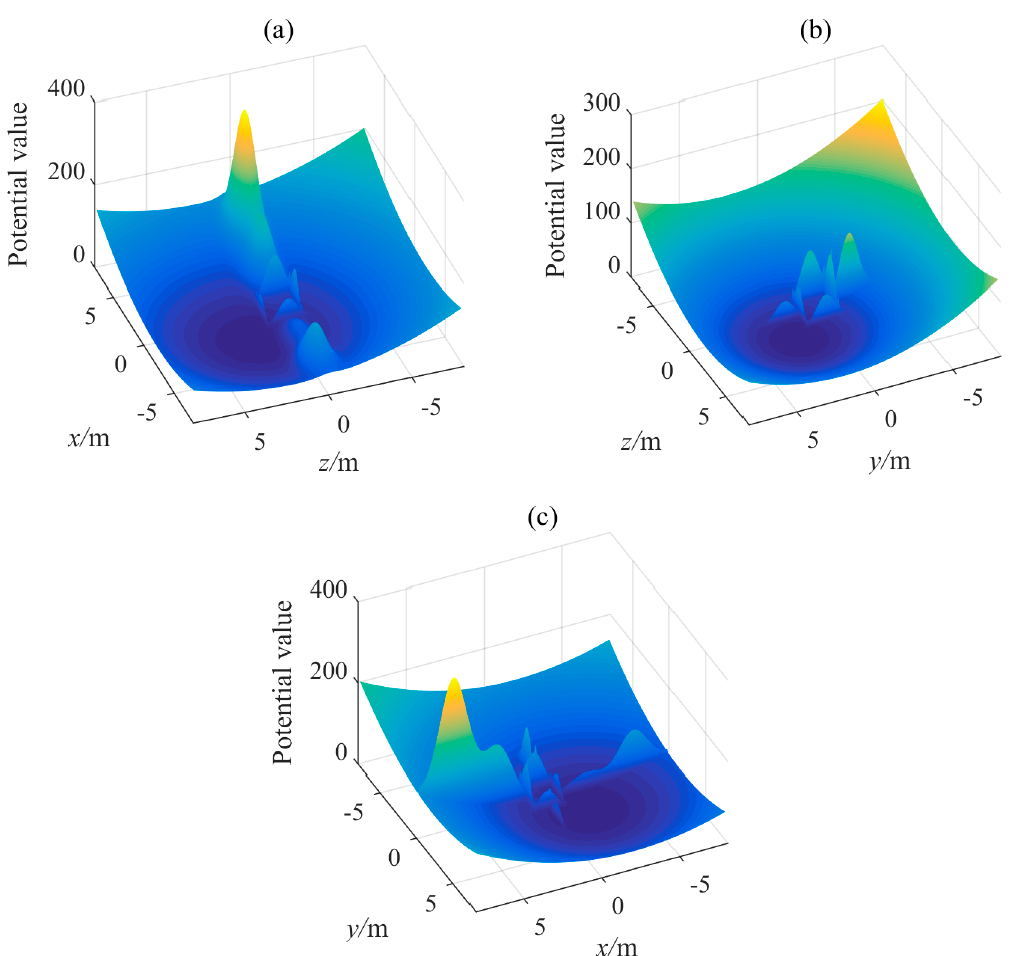
Figure 5. The potential distribution of GMM-based artificial potential function. ( a ) The potential of